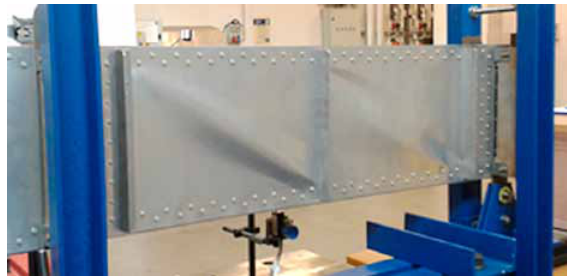
Fig. 6. Specimen 1D, residual deformation after the test